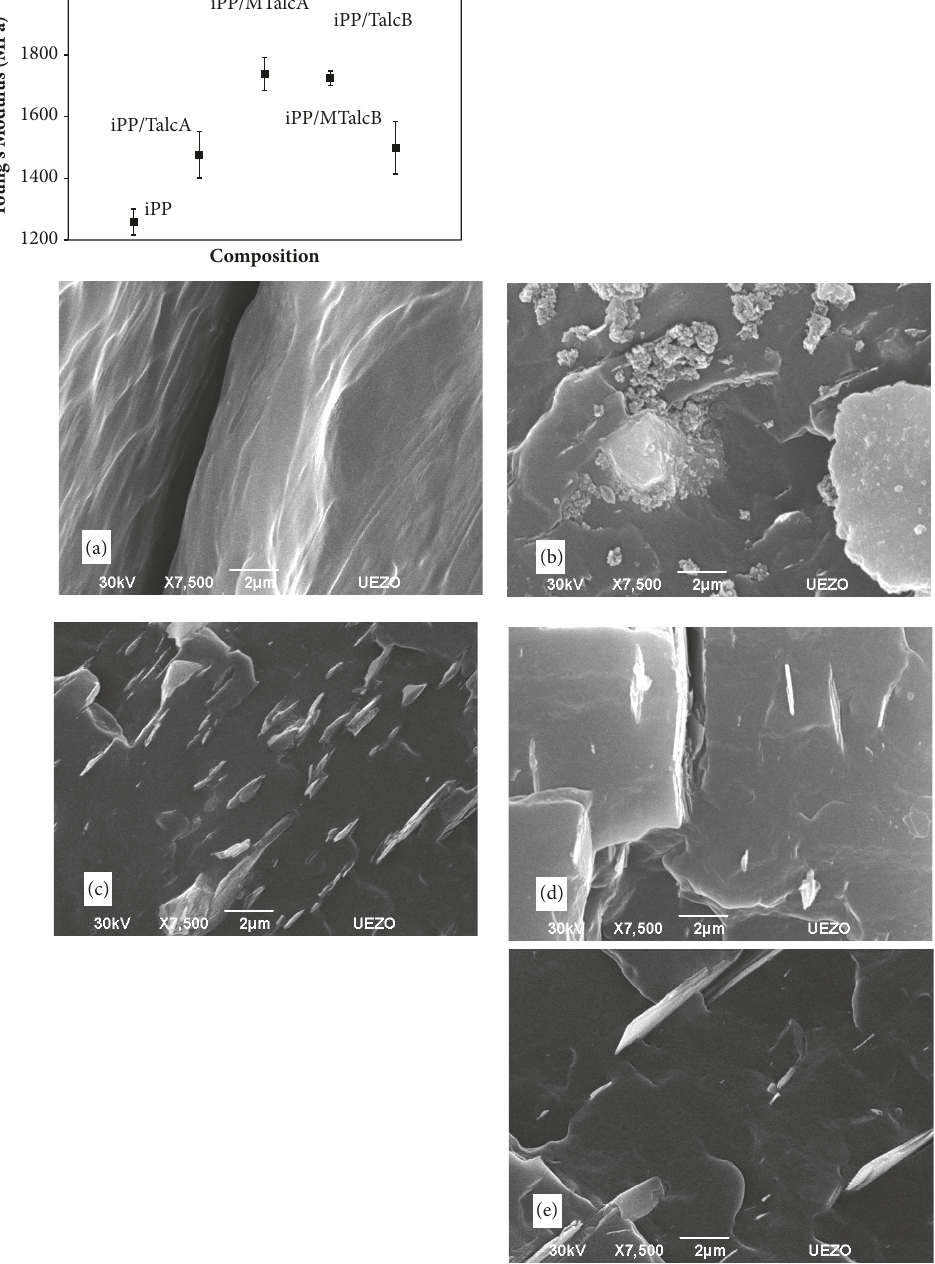
Figure 2: Young’s modulus versus composition iPP/Talc (90/10, wt.%) in different processing procedure: all components being fed simultaneously (iPP/Talc A and iPP/Talc B composites) and from masterbath dilution (iPP/MTalc A and iPP/MTalc B composites). SEM micrographs (a) neat iPP; (b) iPP/Talc A; (c) iPP/MTalc A; (d) iPP/Talc B; and (e) iPP/MTalc